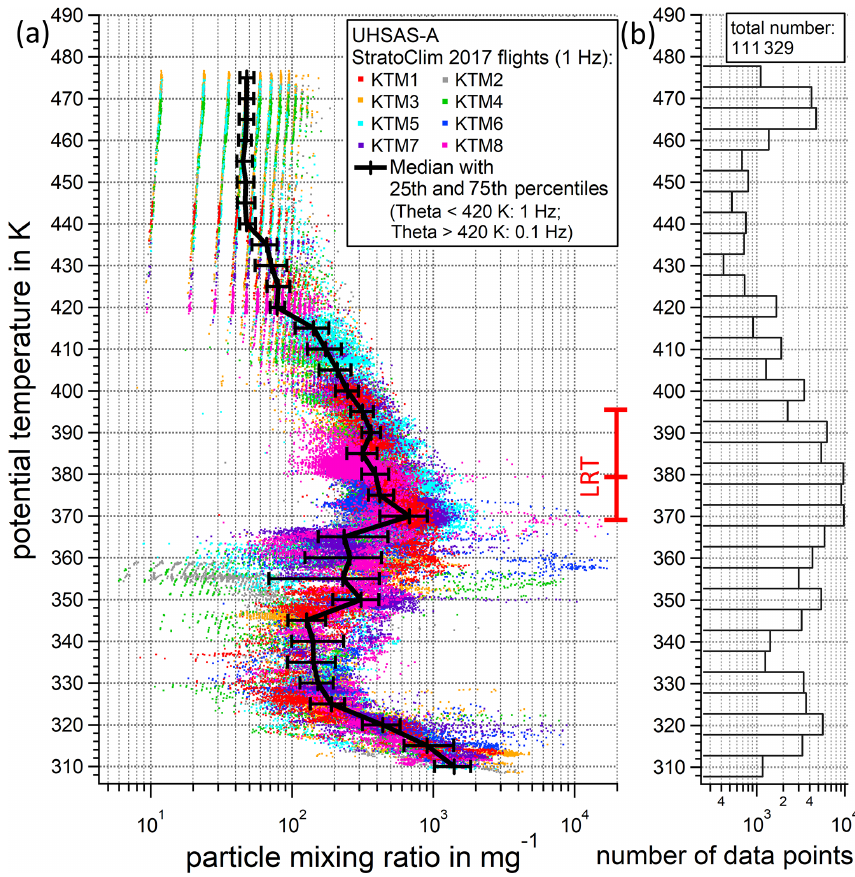
Figure 2. (a) Vertical profile of the particle mixing ratio measured with the UHSAS-A (diameter range of 65nm–1µm) during the StratoClim 2017 measurement campaign, with the potential temperature as the vertical coordinate. The 1Hz resolved data points of the individual measurement flights are marked by individually colored dots. The median profile of all flights is plotted in black in steps of 5K (each over a ± 2 . 5K interval) with the 25th and 75th percentiles, based on the 1Hz data for (cid:50) < 420K and on the 0.1Hz data for (cid:50) > 420K. The red vertical bar indicates the position (minimum, mean, and maximum (cid:50) level) of the lapse rate tropopause (LRT; calculated from the ECMWF reanalysis data) during the campaign period. (b) The number of 1Hz data points included in each 5K potential temperature interval. Each 1Hz data point covers a particle size distribution from 65nm to 1µm particle